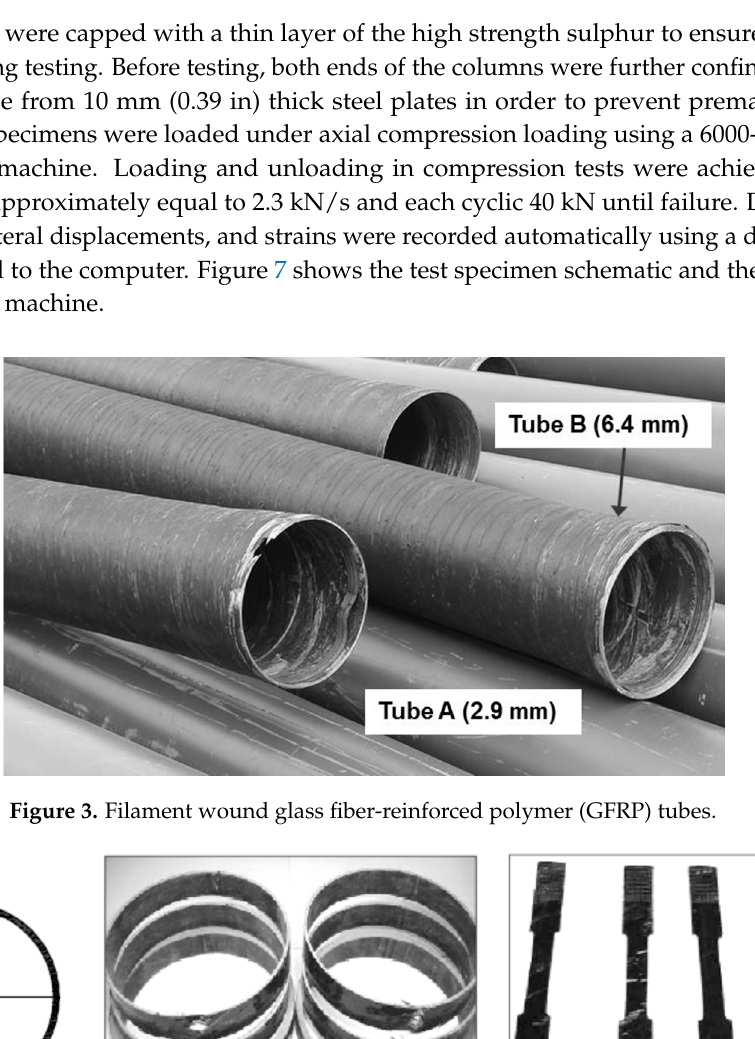
Figure 2. Different steel and fiber-reinforced polymer (FRP) bars used in this study.